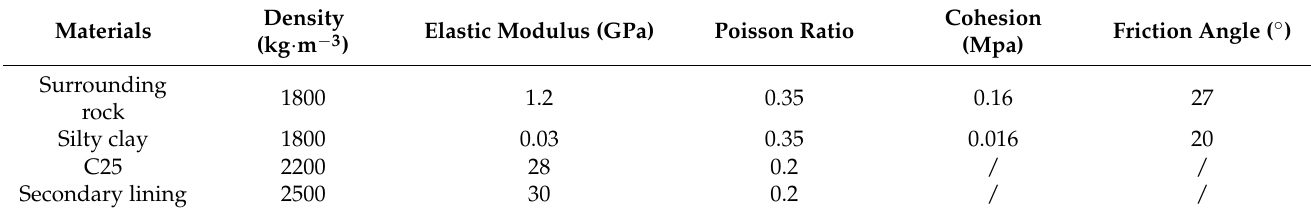
Table 1. Calculation material parameters.